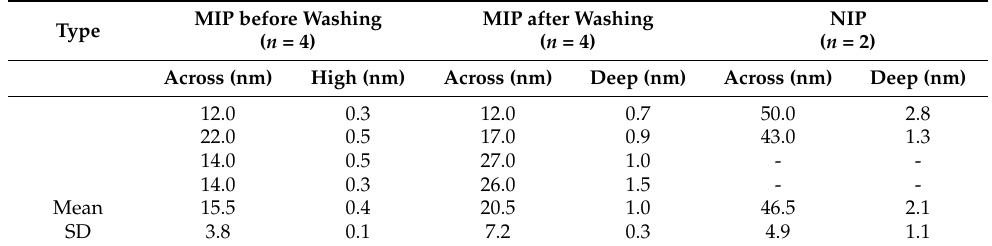
Table 1. Cross-section profiles of AFM images.